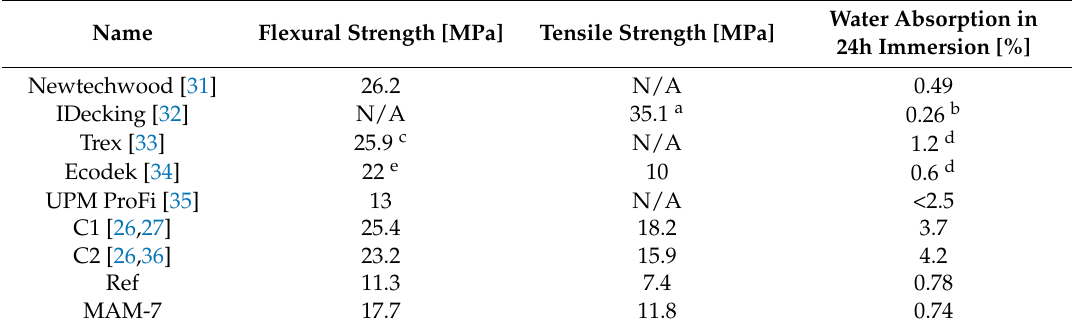
Table 6. Physical properties of commercial WPCs and two produced. N/A denotes not